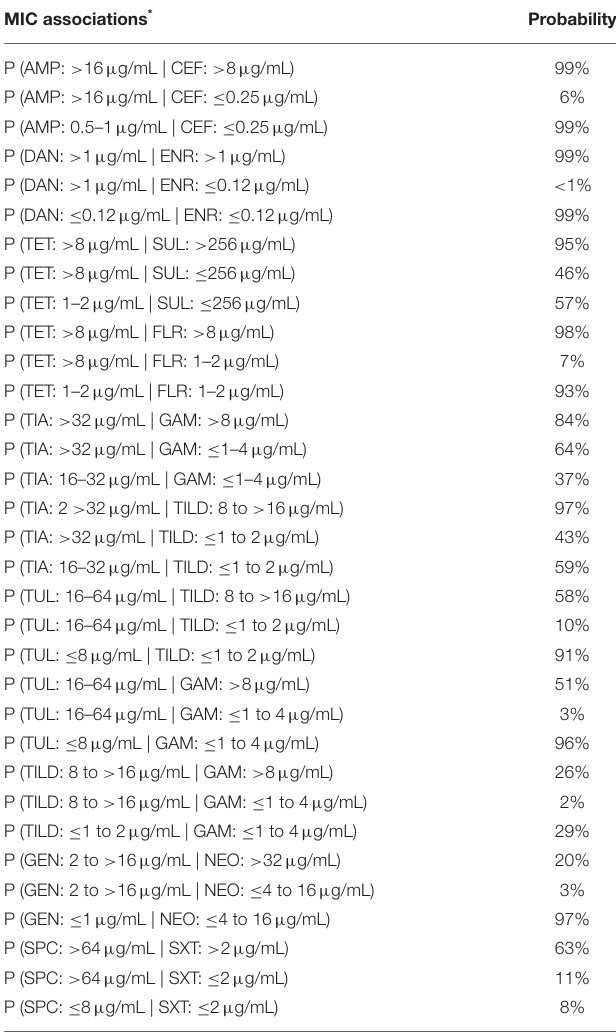
TABLE 2 | Conditional probabilities for MIC associations maintained in the bootstrapped analysis. MIC associations *